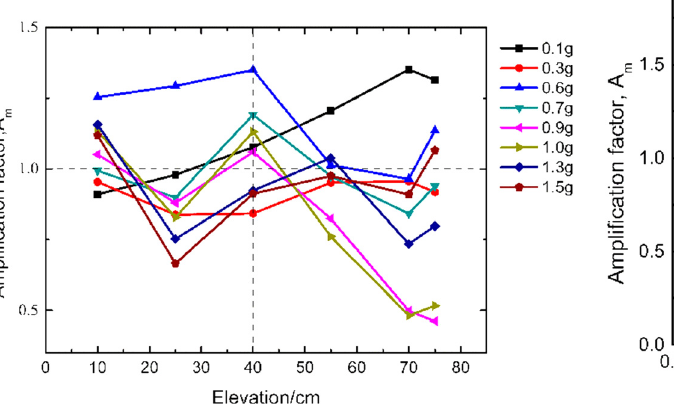
Figure 15: Ampli fi cation factor A m at J1, J3, J5, J7, J9, and J11 against variable elevation.